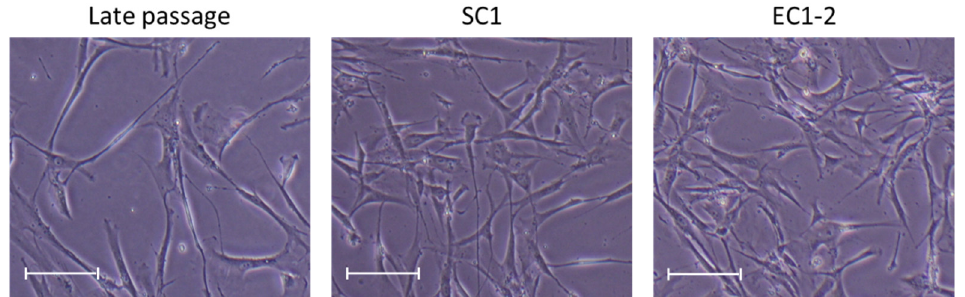
Figure 1. Effects of SC1 and EC1-2 on size of TIG-3 replicative senescence cells. Representative images show the size of each TIG-3 cell at PDL 73–74. Scale bar = 200 µ m.